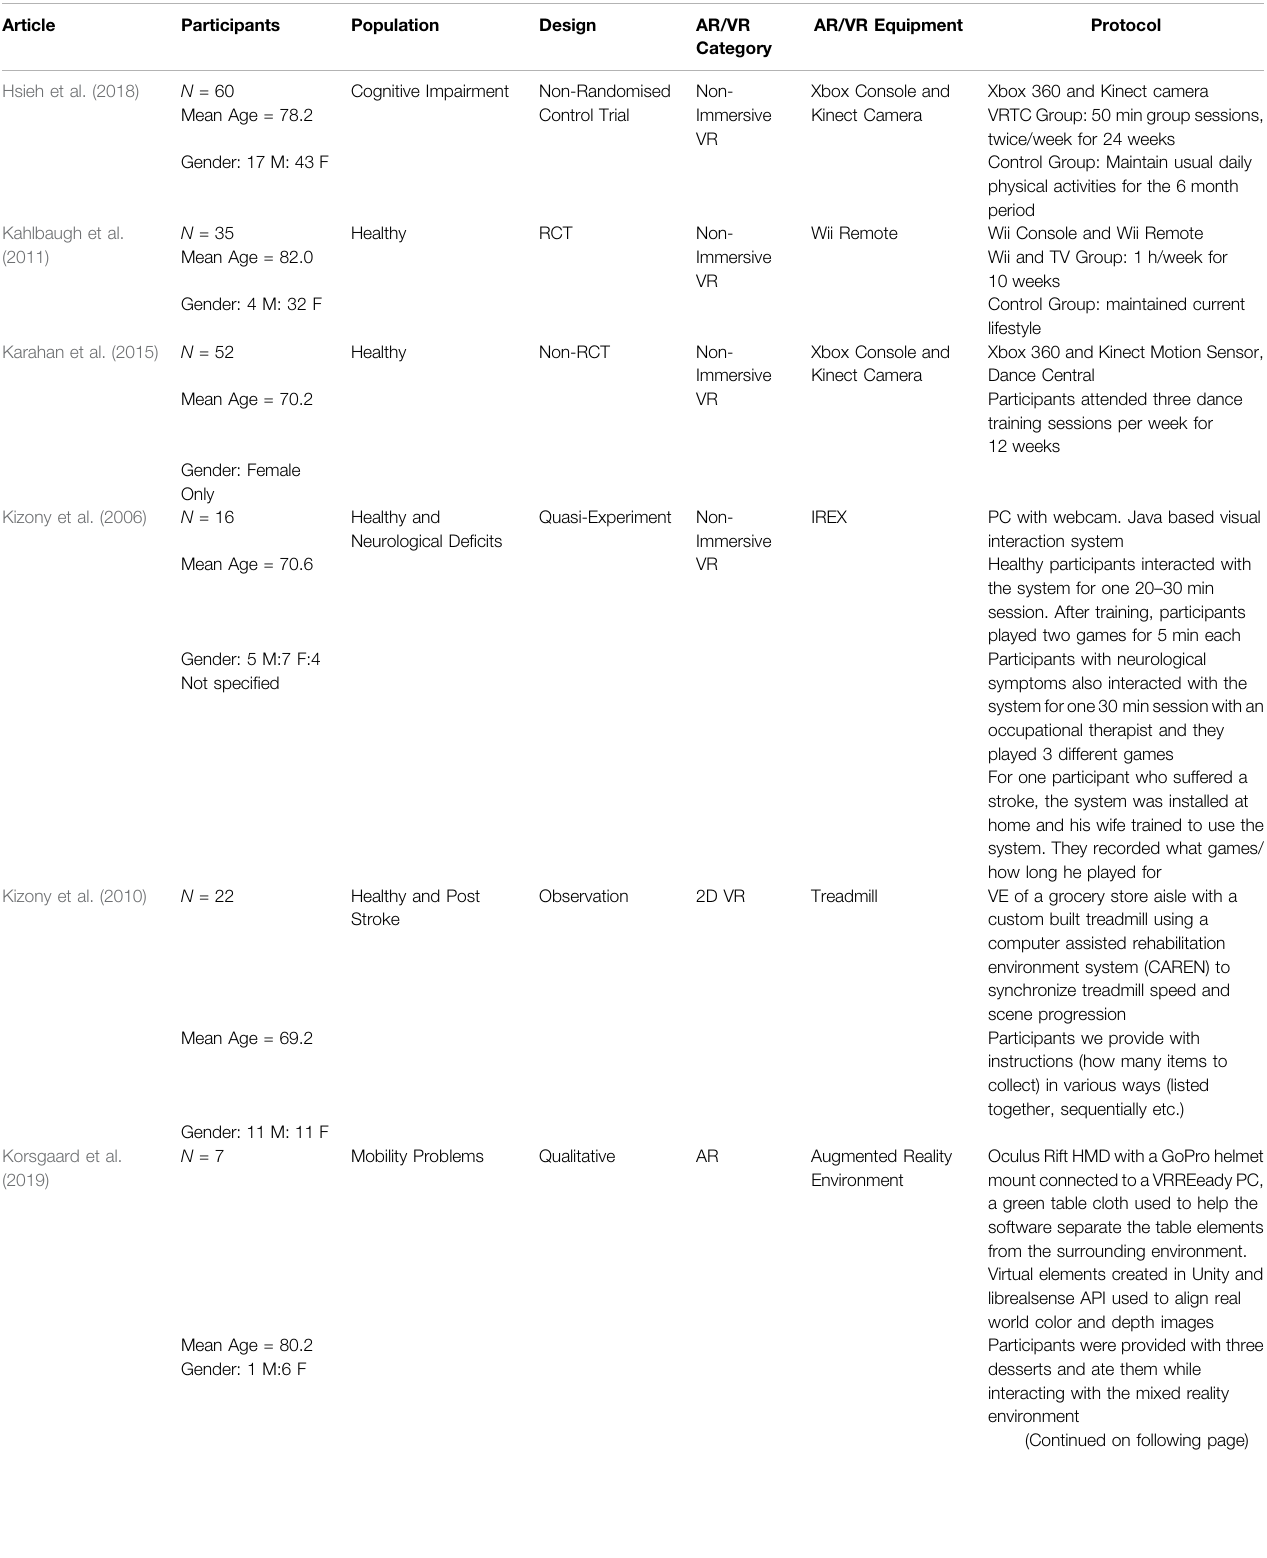
a green table cloth used to help the software separate the table elements from the surrounding environment. Virtual elements created in Unity and librealsense API used to align real world color and depth